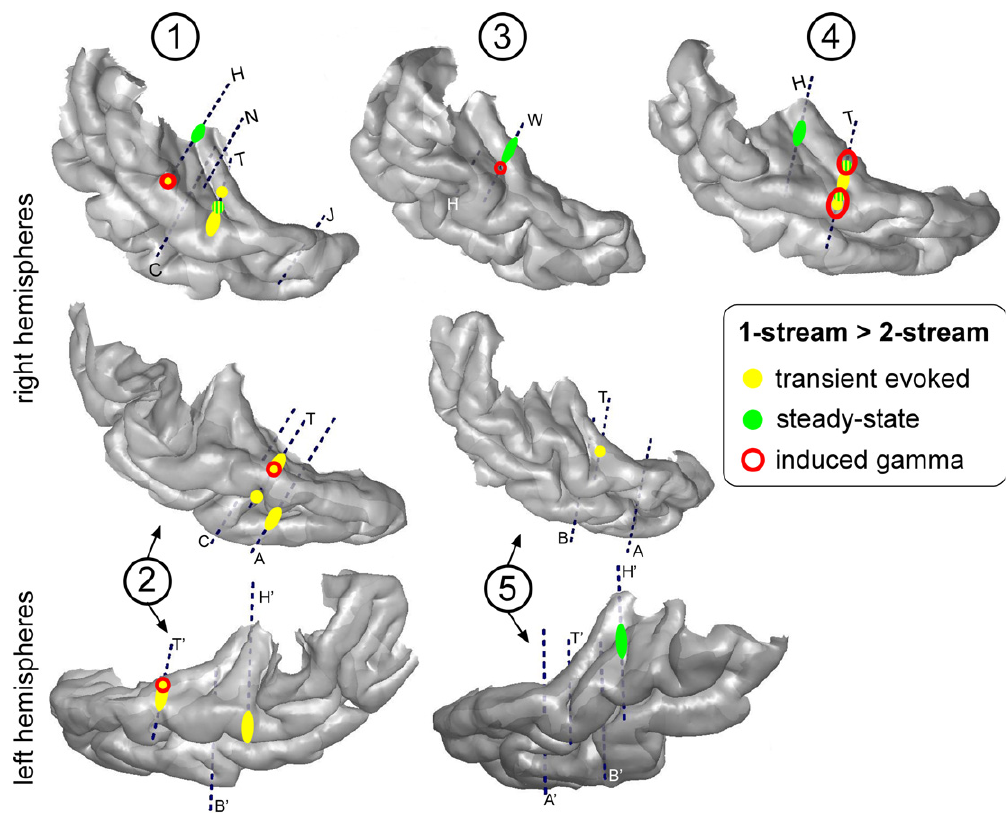
Figure 7. Topographies of the different electrophysiological activities on the 3D rendering of individual temporal cortices. The effects ‘1-stream > 2-stream’ after the onset of part 2 are depicted in yellow for transient evoked responses, green for steady-state activities and red for induced gamma oscil- lations. Effects for induced gamma oscillations and transient evoked responses were mainly found in the lateral STG with a tendency to overlap. Effects for steady-state activities were more medial in the HG and had little overlap with other activities. Each number corresponds to a patient, patients #2 and 5 being implanted in both